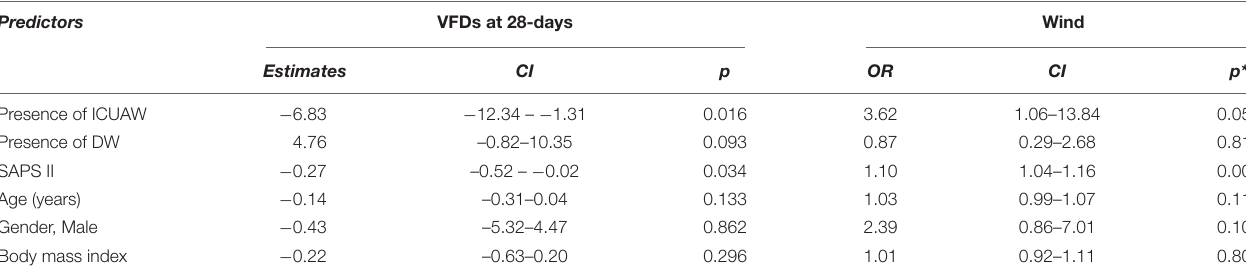
TABLE 2 | Adjusted analysis for mechanical ventilation duration and weaning success as measured by WIND.